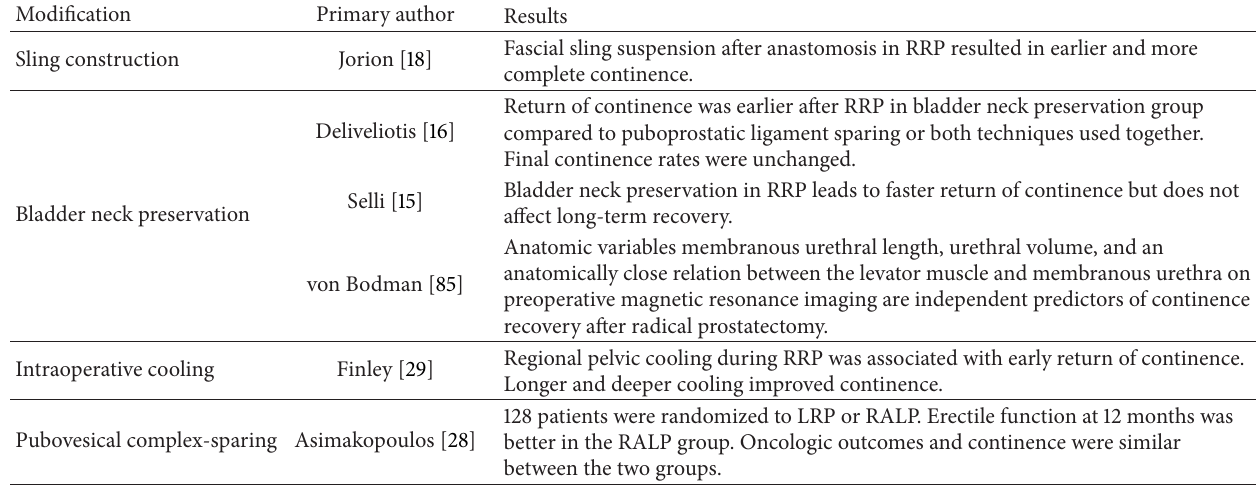
Table 2: Urinary continence.